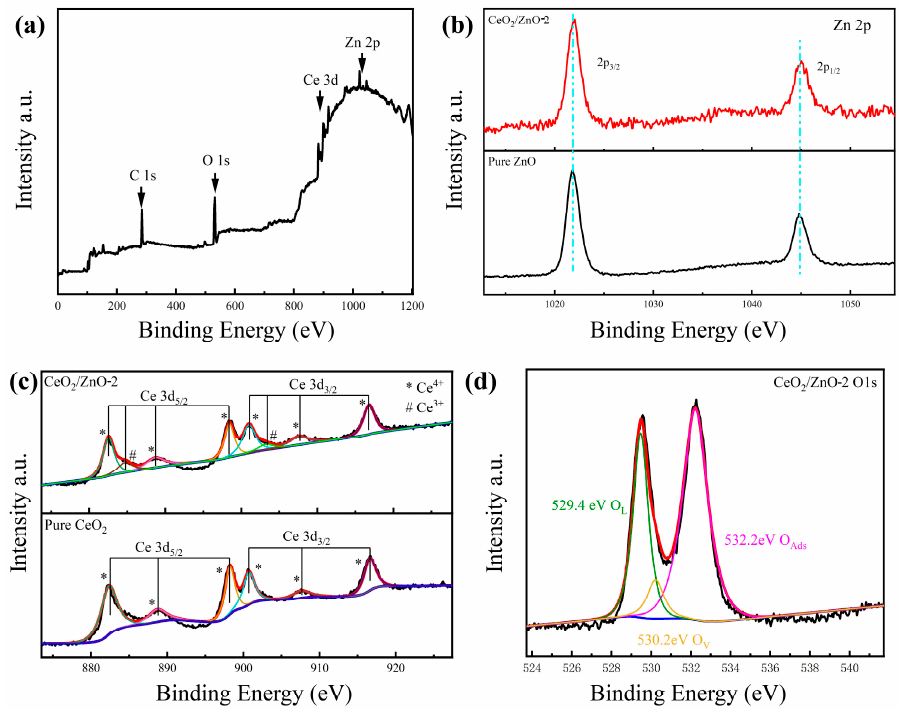
Figure 4. ( a ) Full XPS survey spectra of CeO 2 /ZnO-2. ( b ) Zn 2p peaks of CeO 2 /ZnO-2 composites. ( c ) Ce 3d peaks of CeO 2 /ZnO-2 and pure CeO 2 . ( d ) O1s peaks of CeO 2 /ZnO-2.